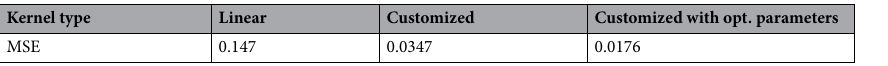
Table 2. Errors in terms of mean squares by different kernels in the high temperature dataset.